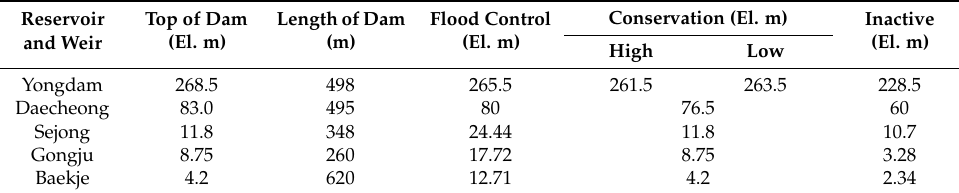
Table 4. Detailed data on the dams and weirs covered in this study.